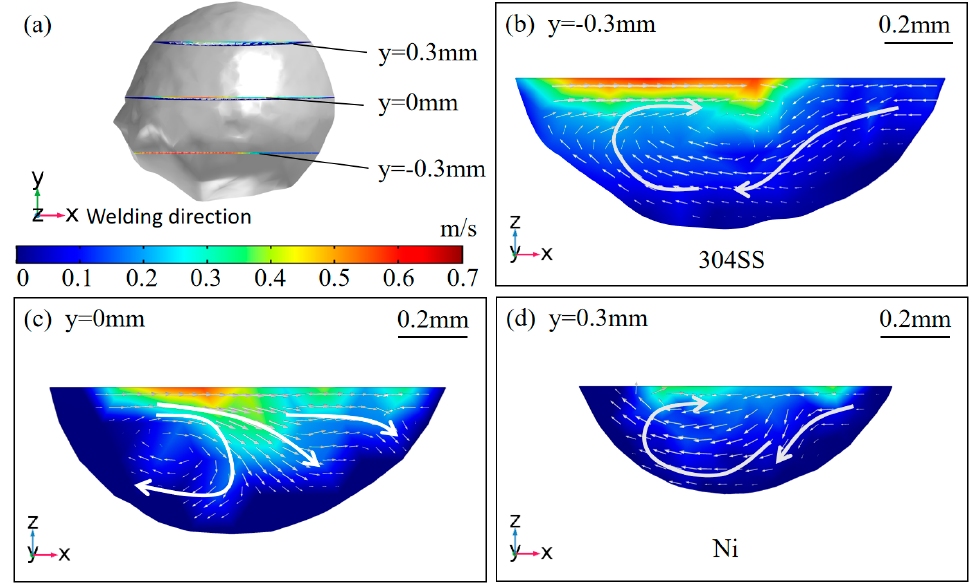
Figure 12. Fluid flow of the molten pool in the AMO for different X–Y sections. ( a ) Overview of sections in the molten pool: ( b ) y = − 0.3 mm; ( c ) y = 0 mm; ( d ) y = 0.3 mm.